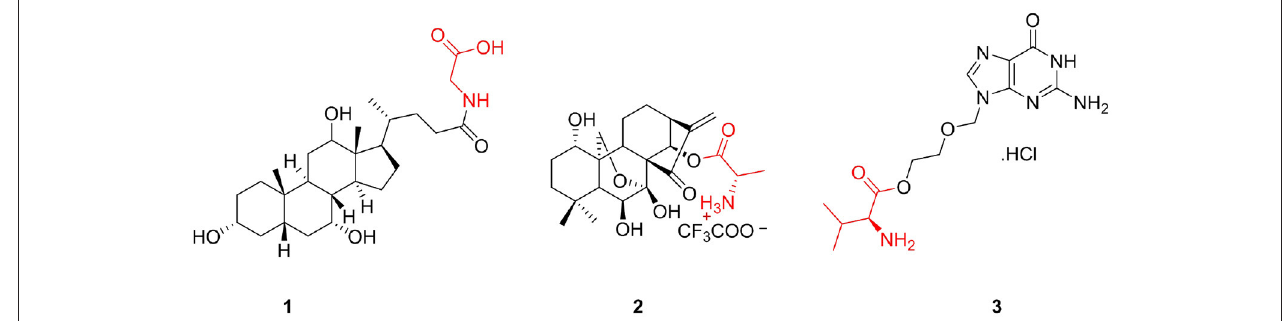
FIGURE 1 | Successful cases of natural product modification with amino acids.